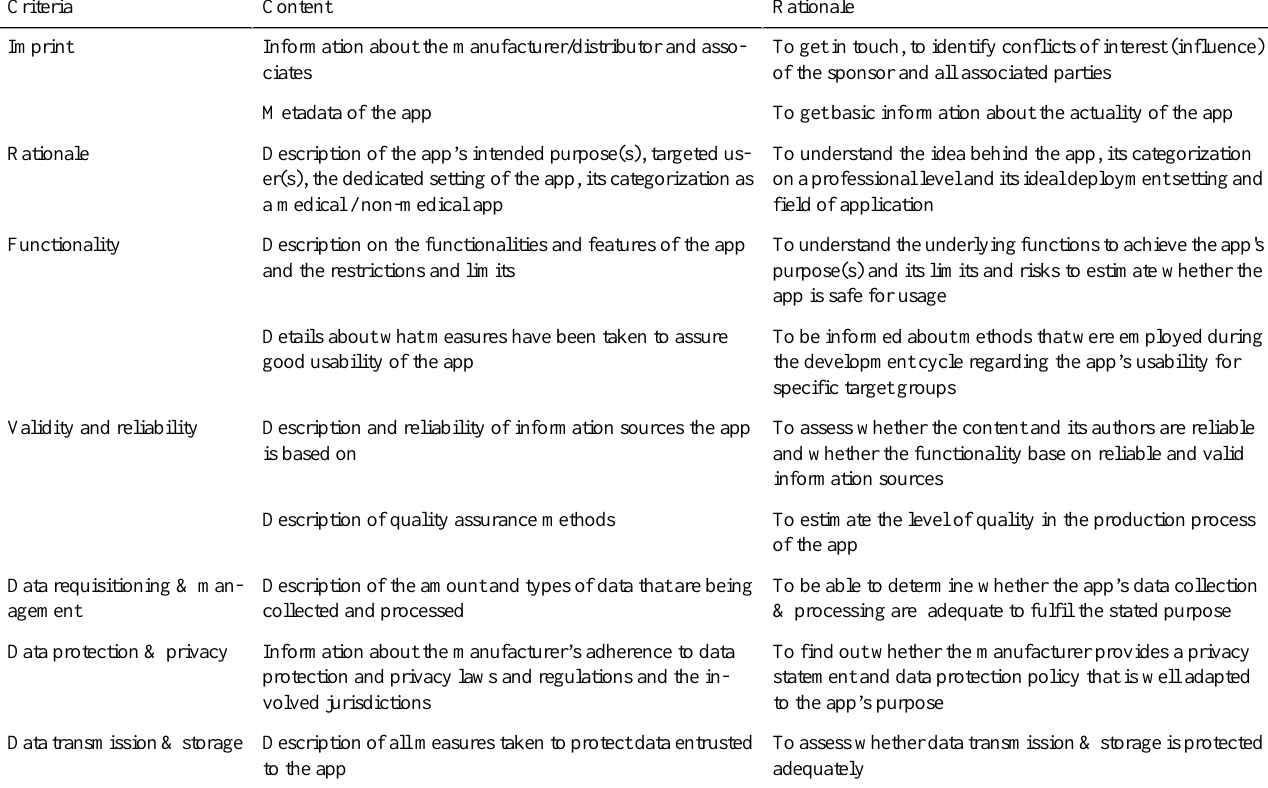
Table 1. Criteria for assessing health apps and medical